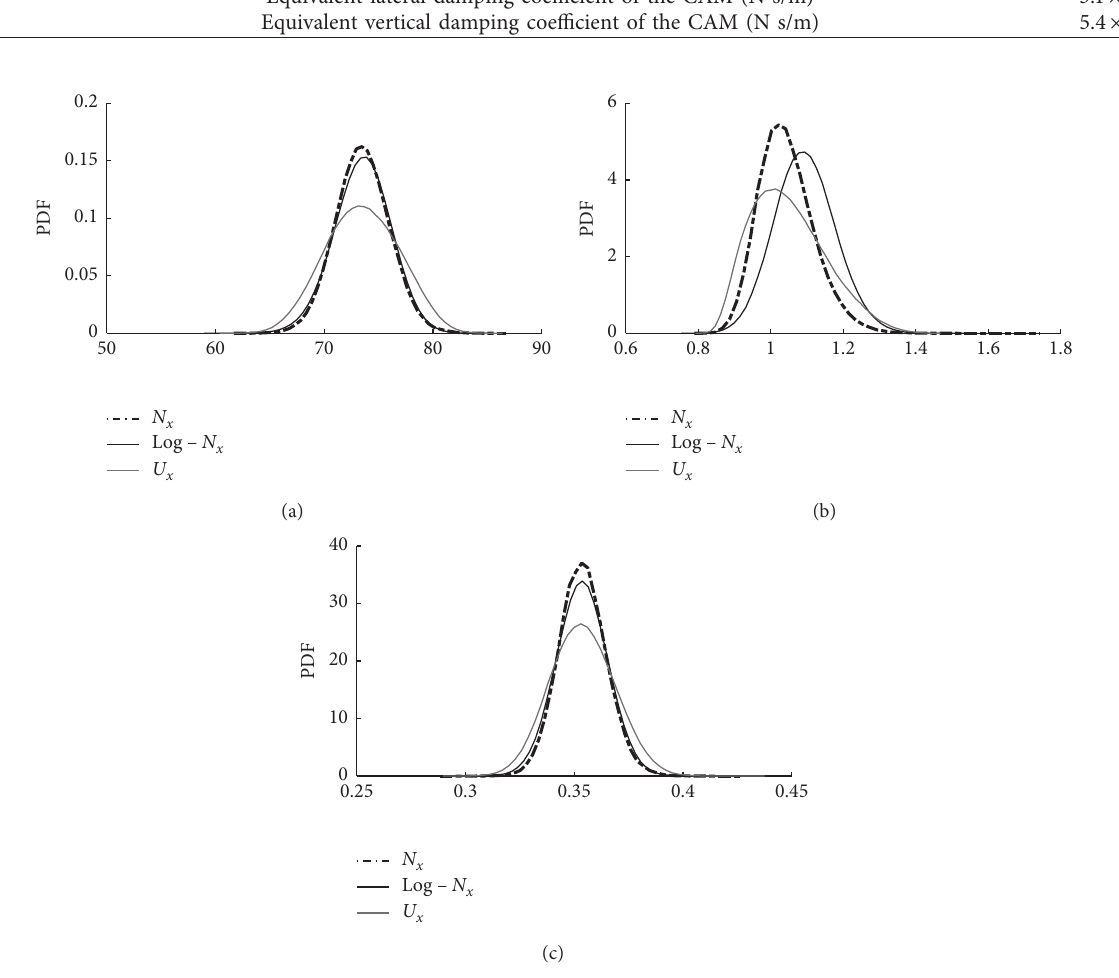
Figure 6: The PDF of dynamic indices specific to different longitudinal distribution of rail pad vertical stiffness. (a) Wheel-rail vertical force; (b) rail vertical displacement; (c) track-slab vertical